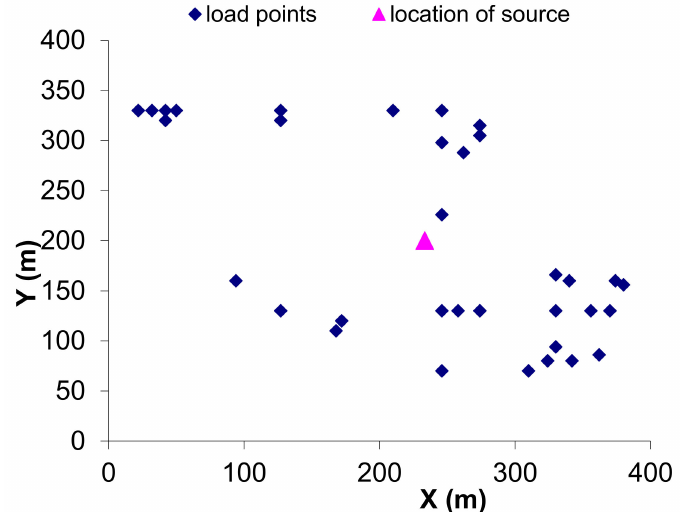
Figure 8. Spatial distribution of load points on the map of village and location of source. The X-axis shows the distance of load or source points from the estimated origin of the map in the west to east direction. The Y-axis shows the distance of load or source points from the estimated origin of the map in the south to north